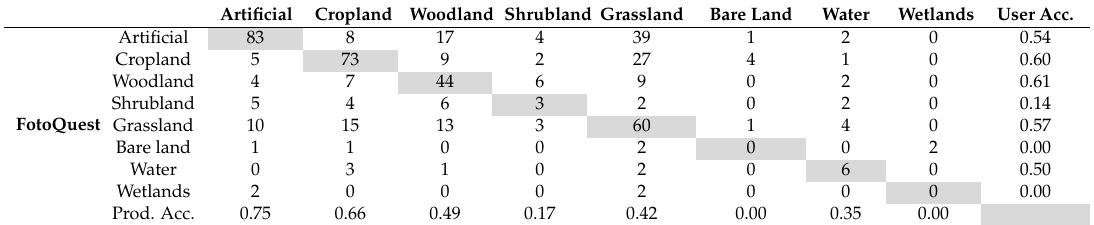
Table 4. Confusion matrix showing level 1 land cover classifications from FotoQuest and LUCAS